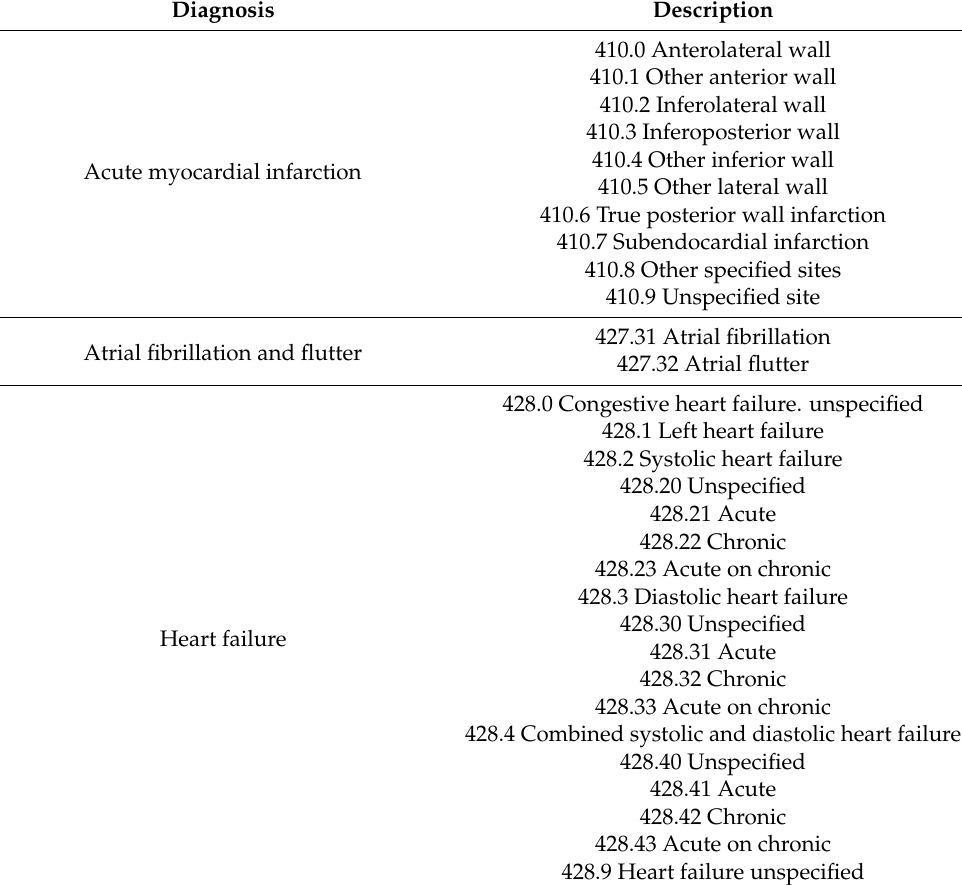
Table 1. ICD-9-CM diagnosis code and description of AMI, AF, and HF